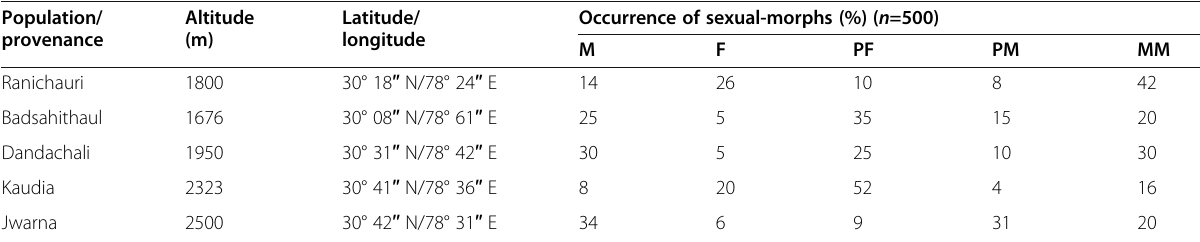
Table 4 Locality and occurrence of sexual-morphs (in percentage) studied in the natural populations of C. deodara , M: male, F: female, MM: mixed-monoecious, PM: predominantly male, PF: predominantly female Population/ provenance